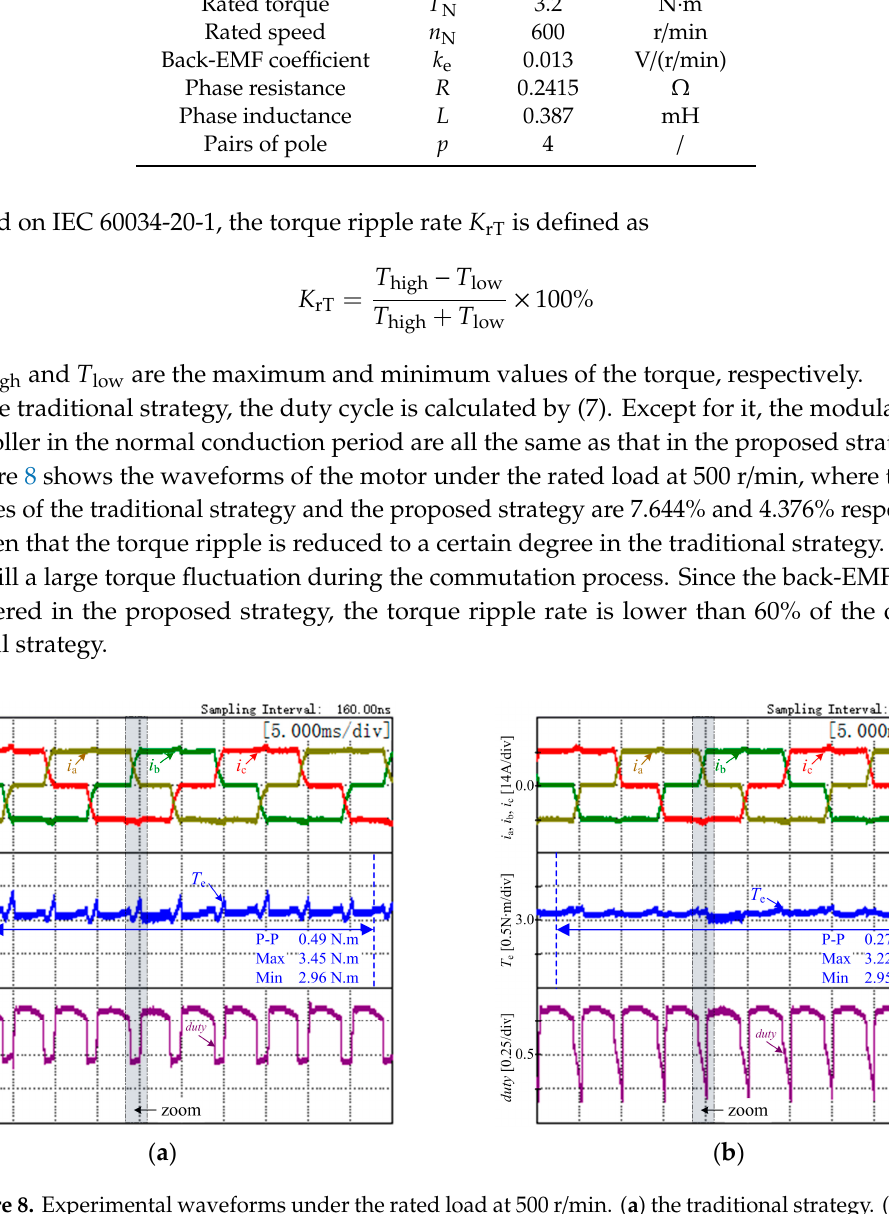
Figure 8. Experimental waveforms under the rated load at 500 r/min. ( a ) the traditional strategy. ( b ) the proposed strategy.